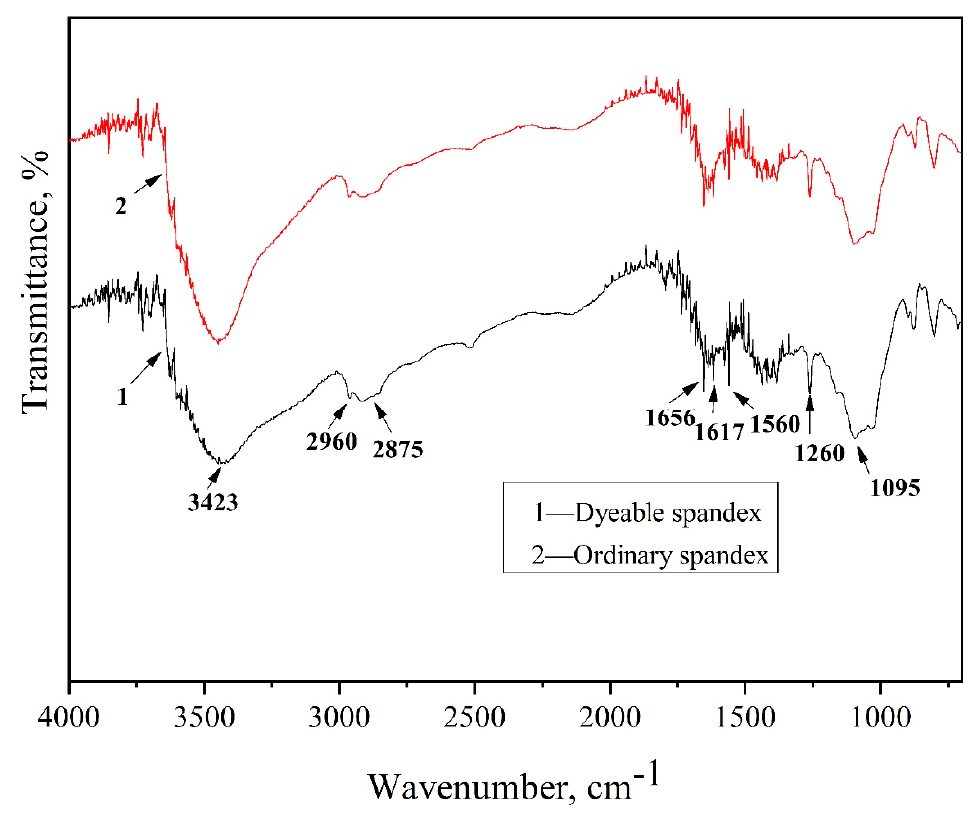
Figure 5. Infrared spectrum of dyeable spandex and ordinary spandex.